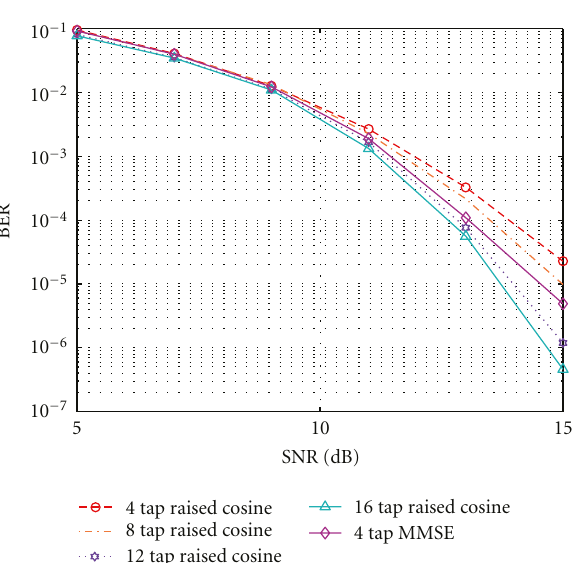
Figure 8: BER versus SNR for ME2PRIV channel with various in- terpolation filters.